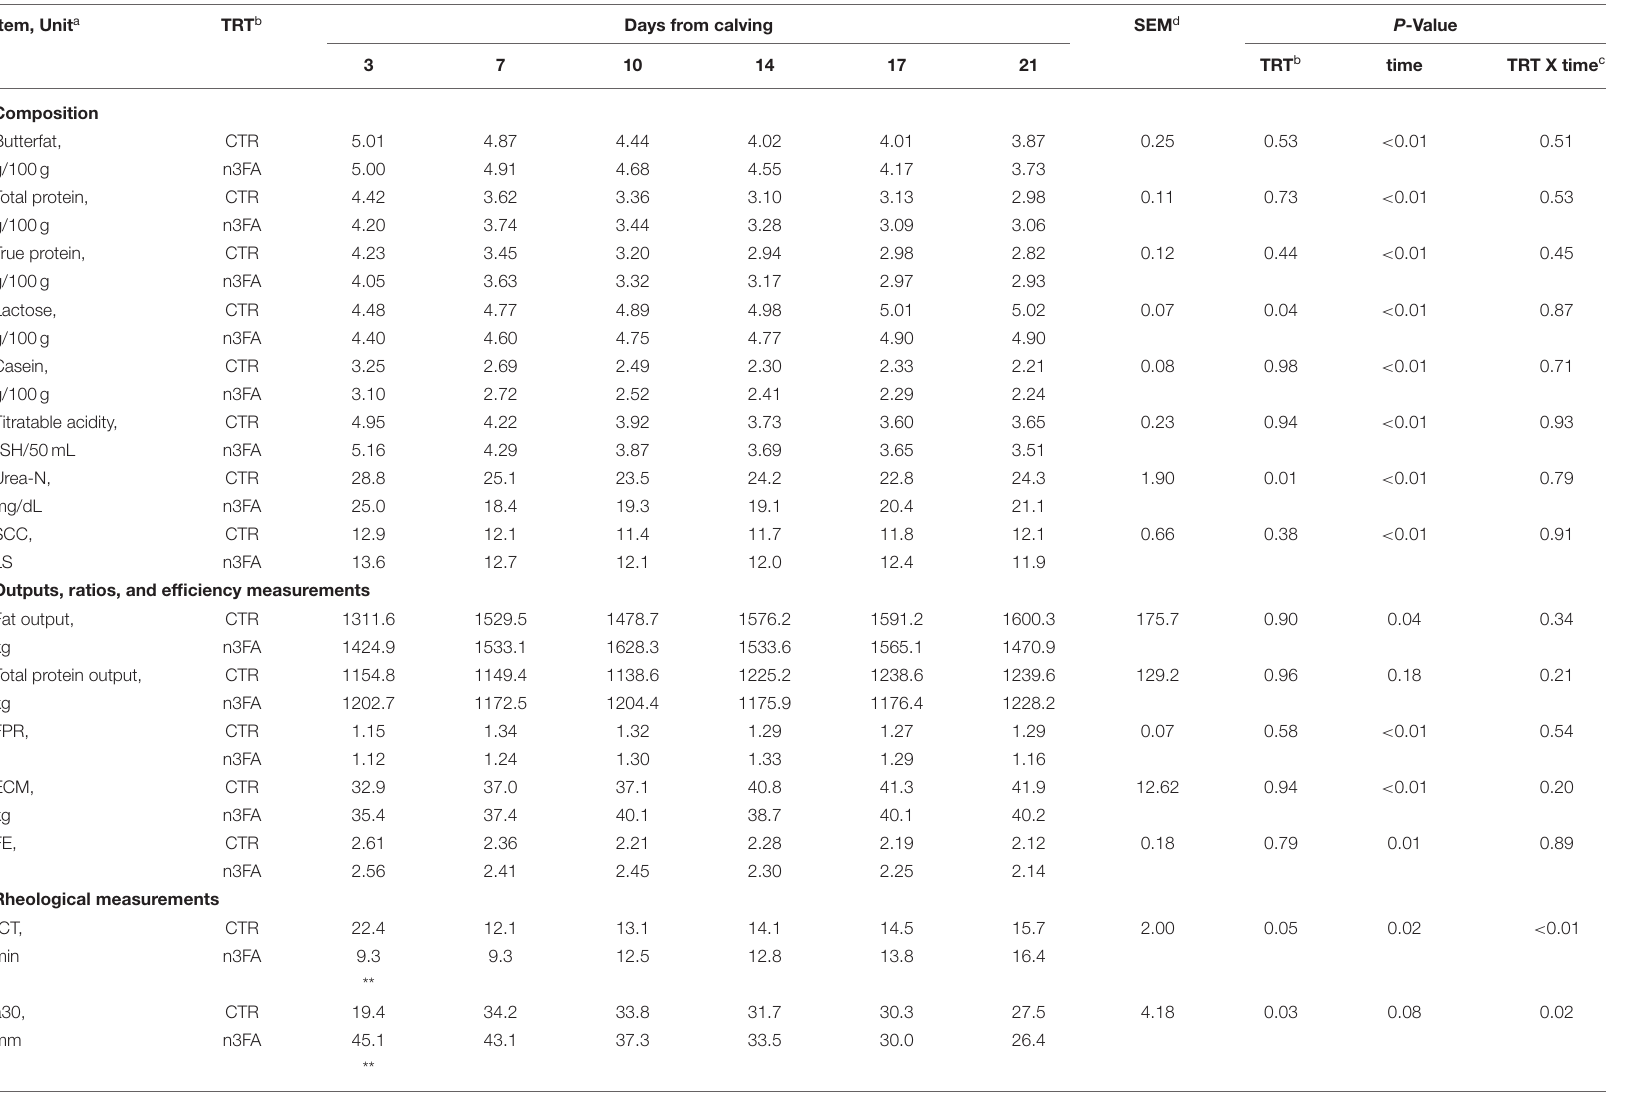
TABLE 5 | Milk composition, somatic cells count and rheological measurements, and feed efficiency measurement in dairy cows infused with 150ml of sterile saline or 150ml of a 10% solution containing purified fish oil rich in long-chained omega-3 fatty acids at 12, 24, and 48h after calving. Item, Unit